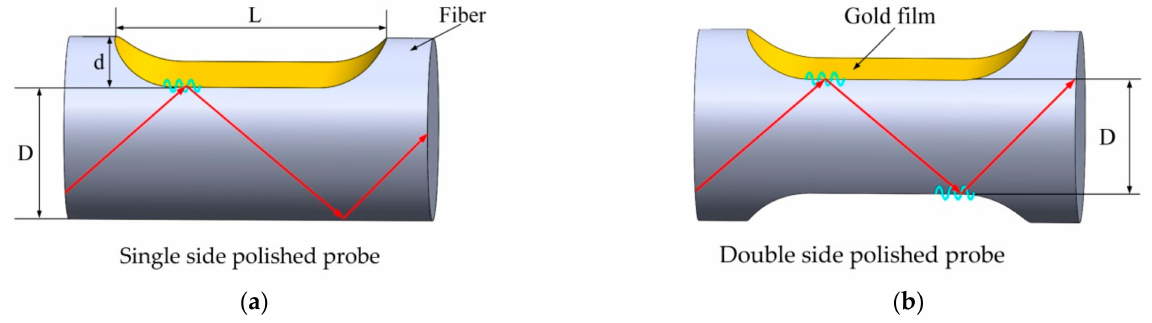
Figure 1. The schematics of the ( a ) single and ( b ) double-sided polished fiber surface plasmon resonance (SPR) probes. D is the remaining diameter of the side polished region, L is polished region length, and d is the polished